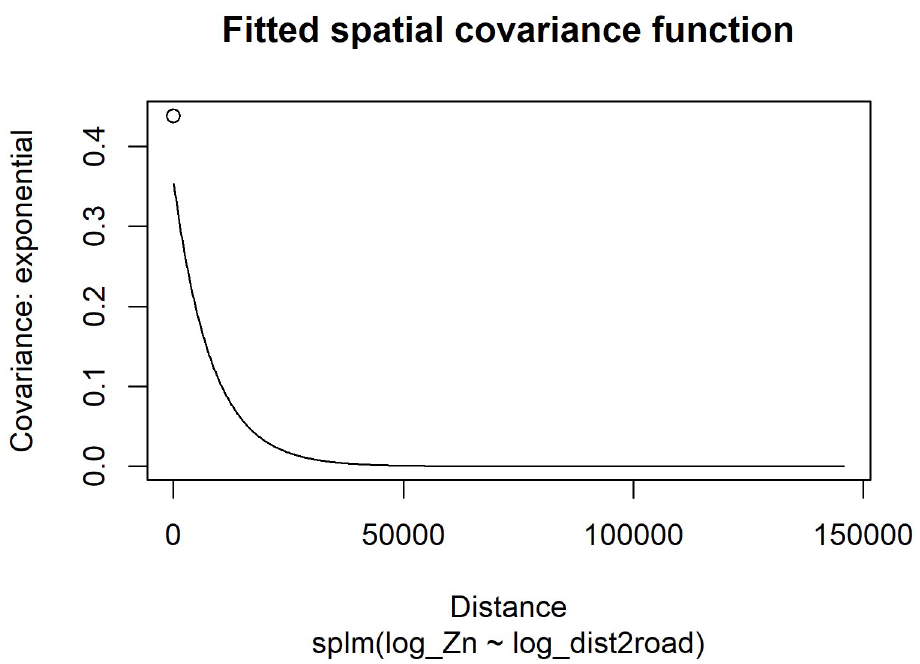
Fig 2. Empirical spatial covariance of the fitted model. The open circle at a distance of zero represents the s 2 The solid line at positive distances represents s 2